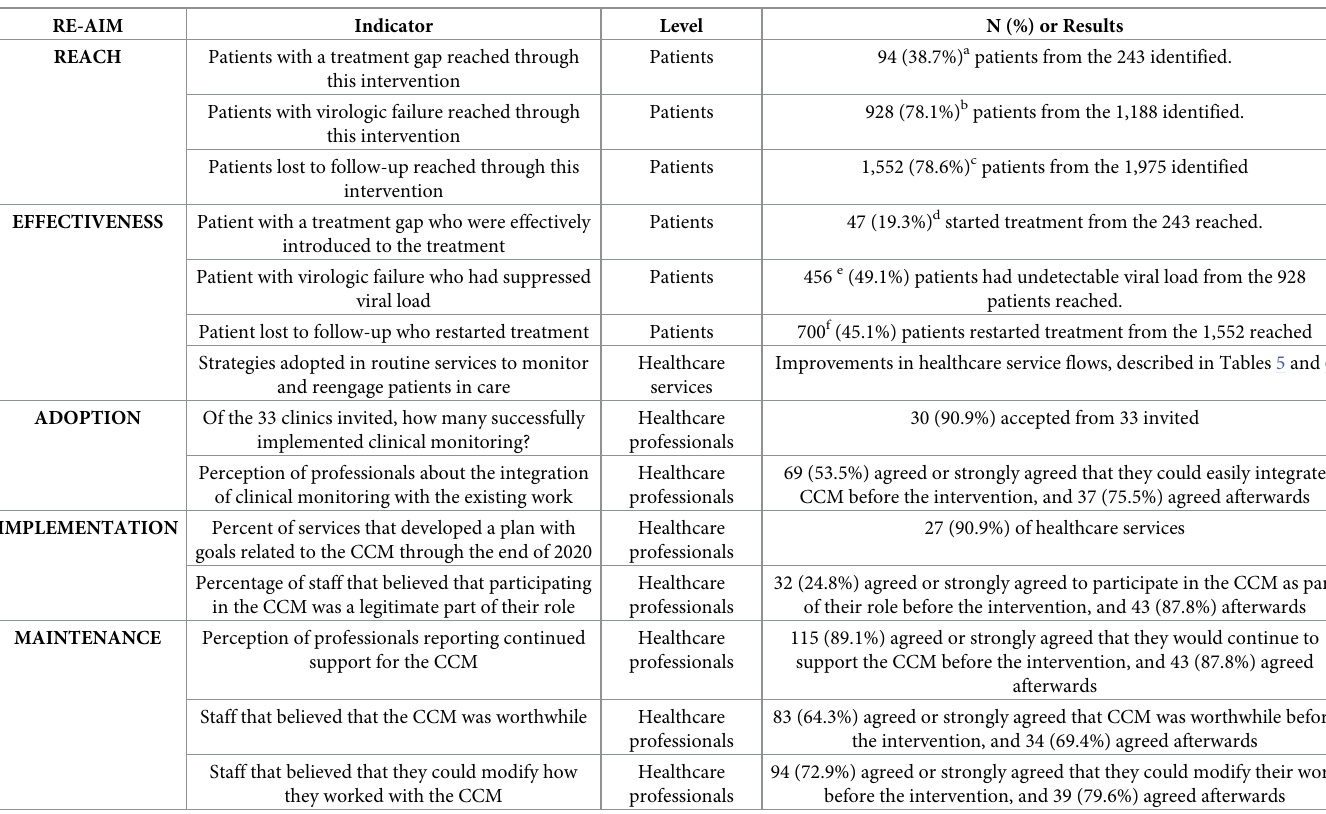
Table 8. Intervention results according to the RE-AIM